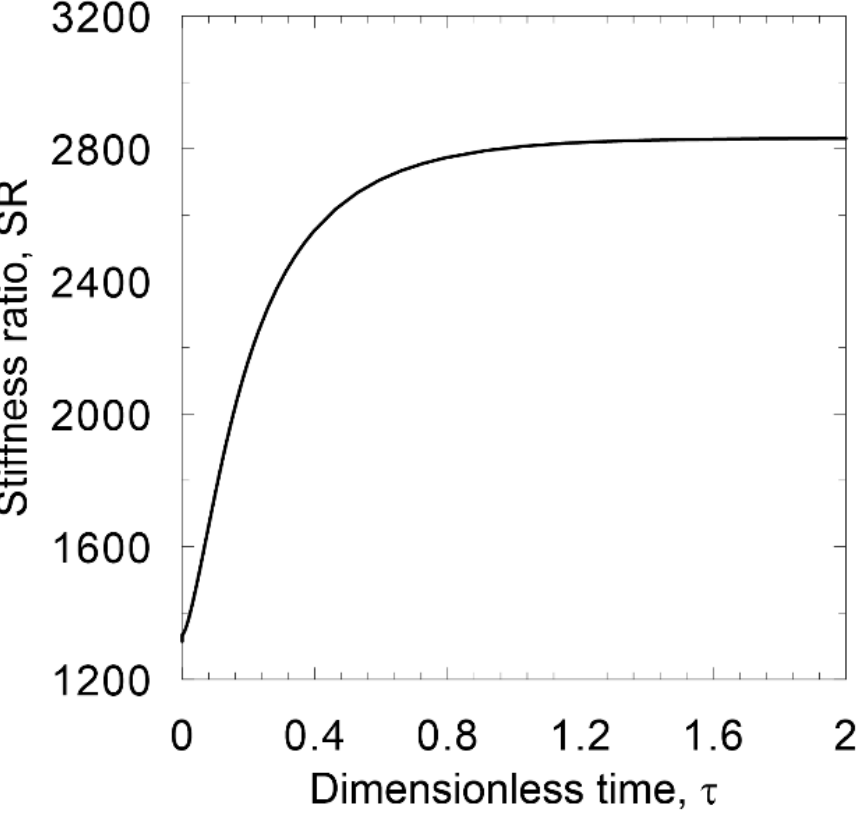
Figure 4. Stiffness ratio of the system of differential equations obtained from the application of method of lines to the exact model.